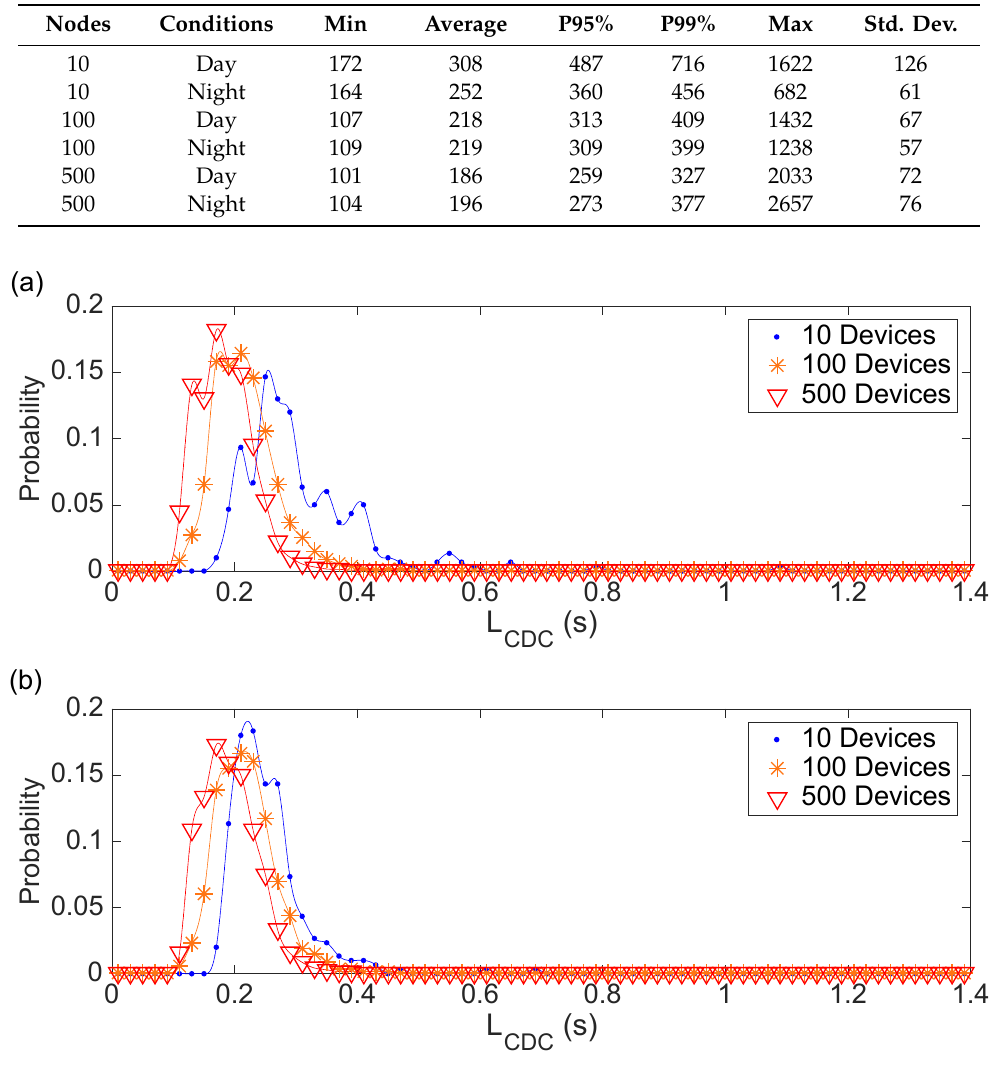
Figure 8. Distribution of the L CDC (latency introduced by the database) collected in the scalability experiments varying the number of devices and the moment of the day: ( a ) during the day; ( b ) during the night. Table 8. Statistics of the L CDC (latency introduced by the database) collected in the scalability experiments. All values are in milliseconds.